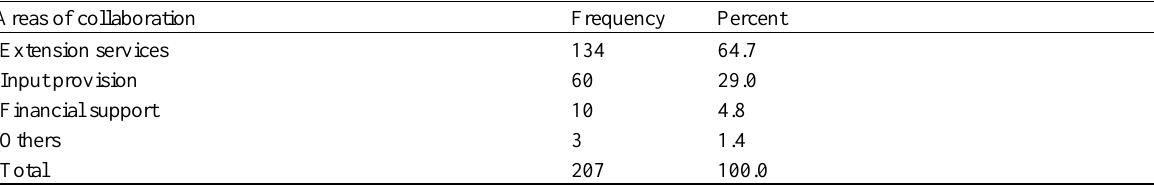
Table 8: Areas in which Partners Collaborate